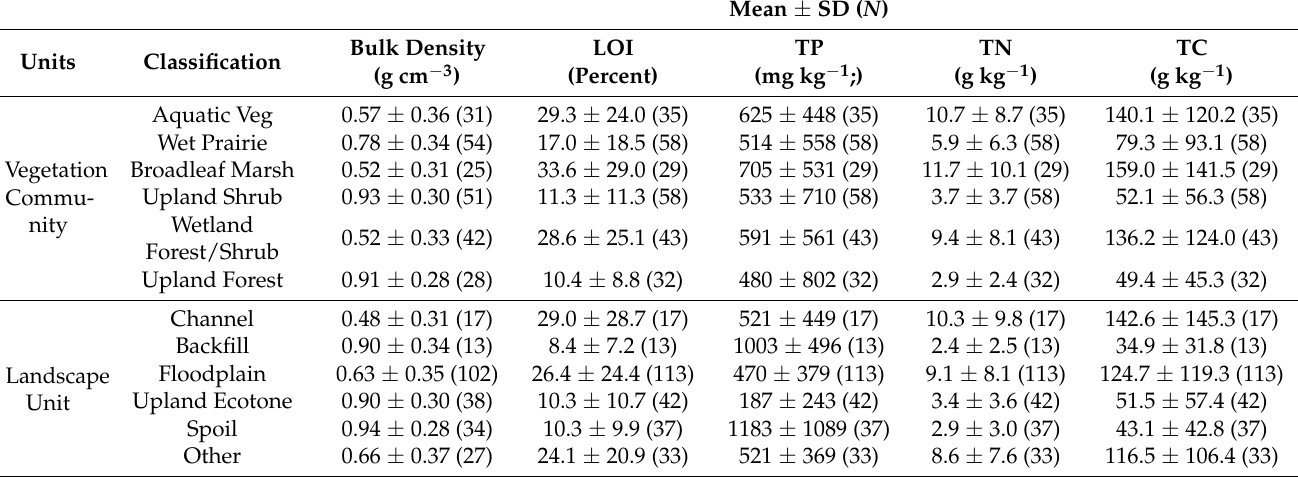
Table 4. Soil summary statistics by vegetation community and landscape unit across the Kissimmee River floodplain (Phases I and II/III). Values are represented as mean ± standard deviation (sample size) for bulk density, loss-on-ignition (LOI), total phosphorus (TP), total nitrogen (TN), and total carbon